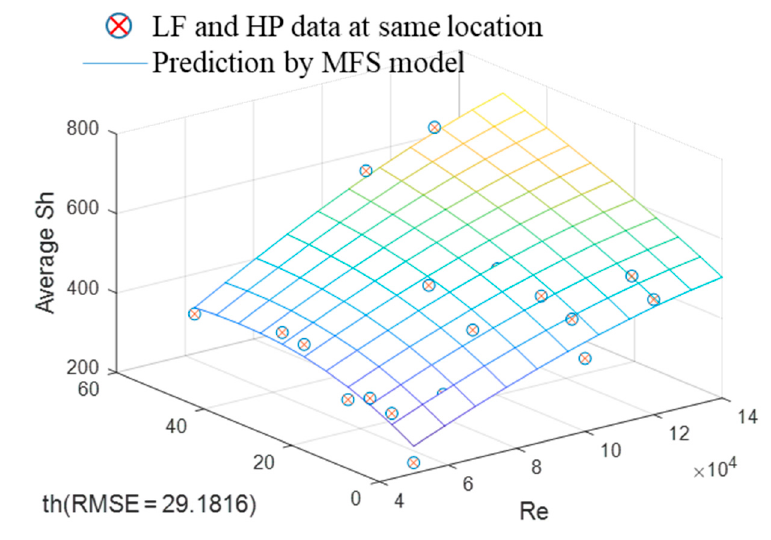
Figure 8. Prediction of averaged HTC by MFS model.